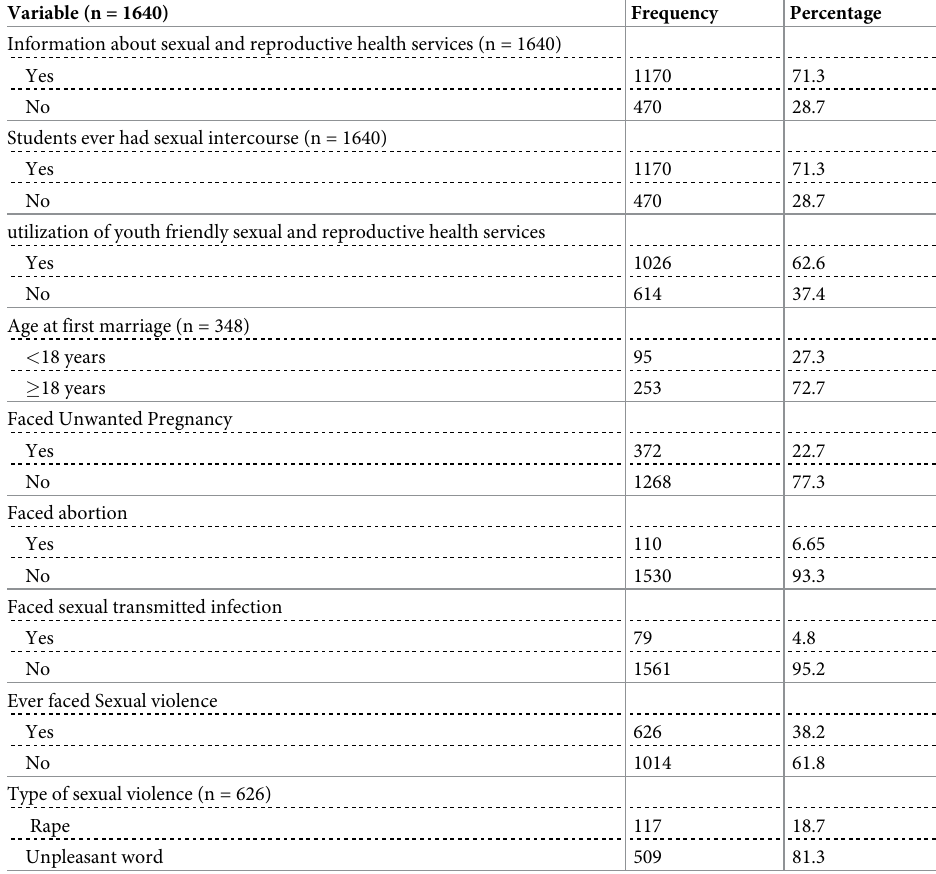
with their parents about unsafe sex (Table 3). Respondents discussed with their mother 371 (79.9%) about early marriage. Factors associated with youth-parent communications Variables with P < 0.2 in binary logistic regression model were entered in to multivariable logistic regression. Multivariable logistic regressions revealed that educational status, marital Table 2. Reproductive health factors among female night students in Amhara Region, Ethiopia, 2018. Variable (n =